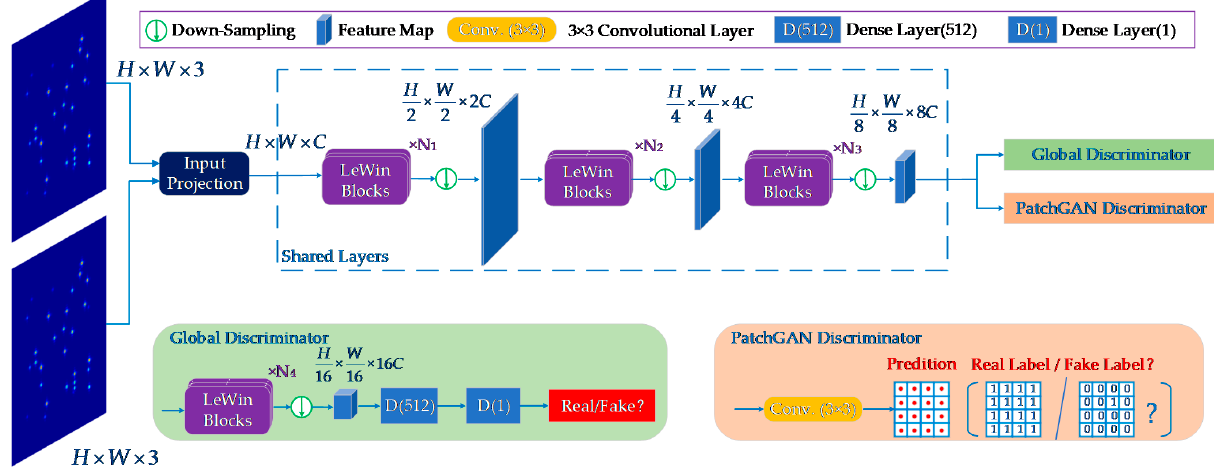
Figure 4. The architecture of the proposed discriminator.